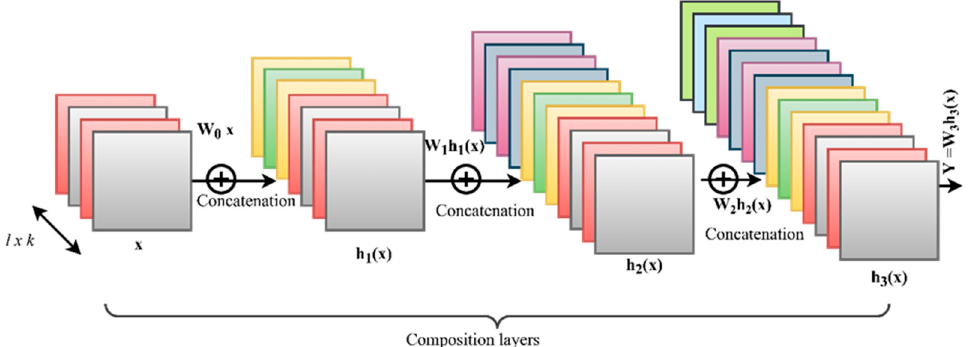
Figure 4. Working principle of a dense block.